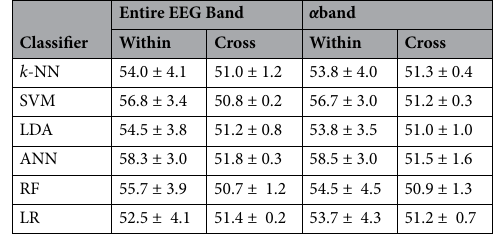
Table 3. Accuracy (mean and standard deviation) considering a priori knowledge i.e. asymmetry—within- subject (Within) and cross-subject (cross).